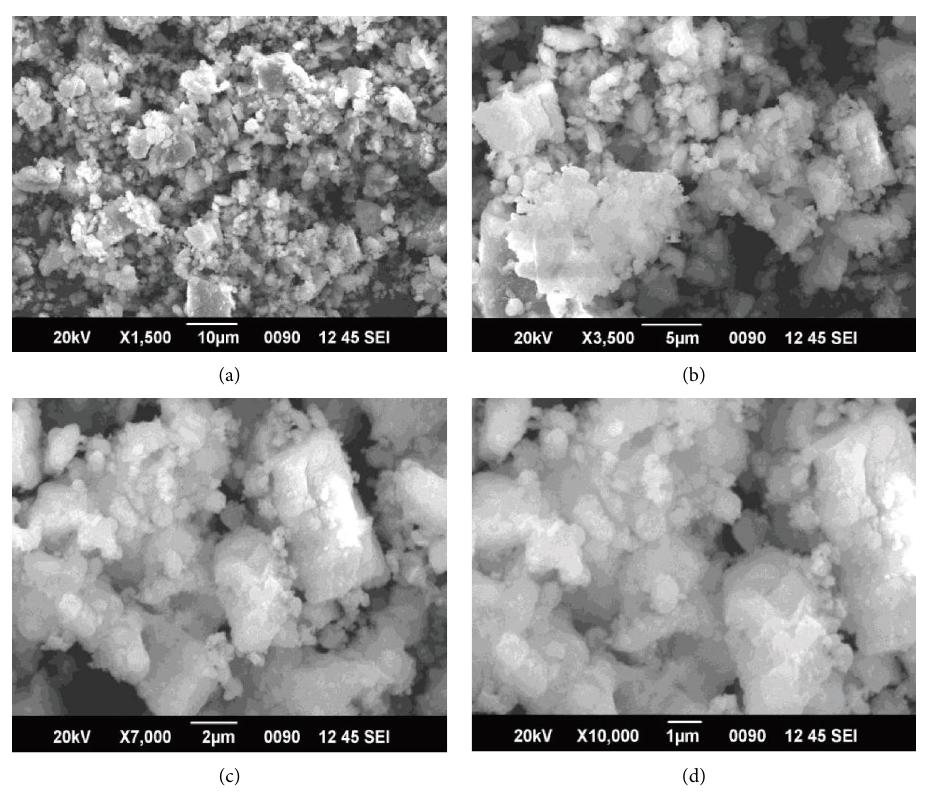
Figure 4: SEM images of the synthesized HAp NPs, at diferent magnifcations.